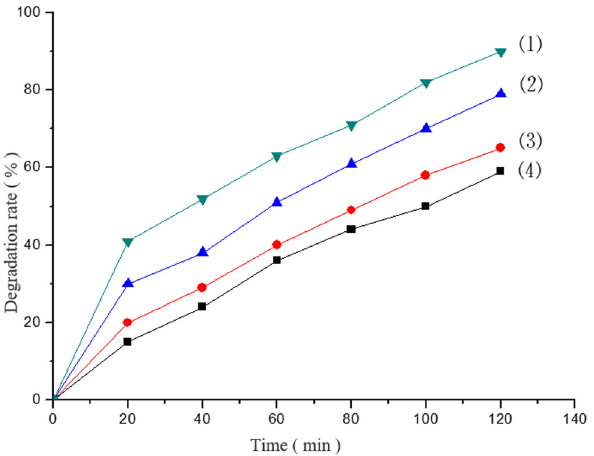
Figure 10: Ce/Ag/ZnO and Ag/ZnO sample degradation rates of the methyl orange contrast curve after adding di ff erent surfactants. ( 1 ) and ( 2 ) to join surfactant PAAS Ce/Ag/ZnO and Ag/ZnO samples, respectively; ( 3 ) and ( 4 ) are Ce/Ag/ZnO and Ag/ZnO samples with added SDBS,